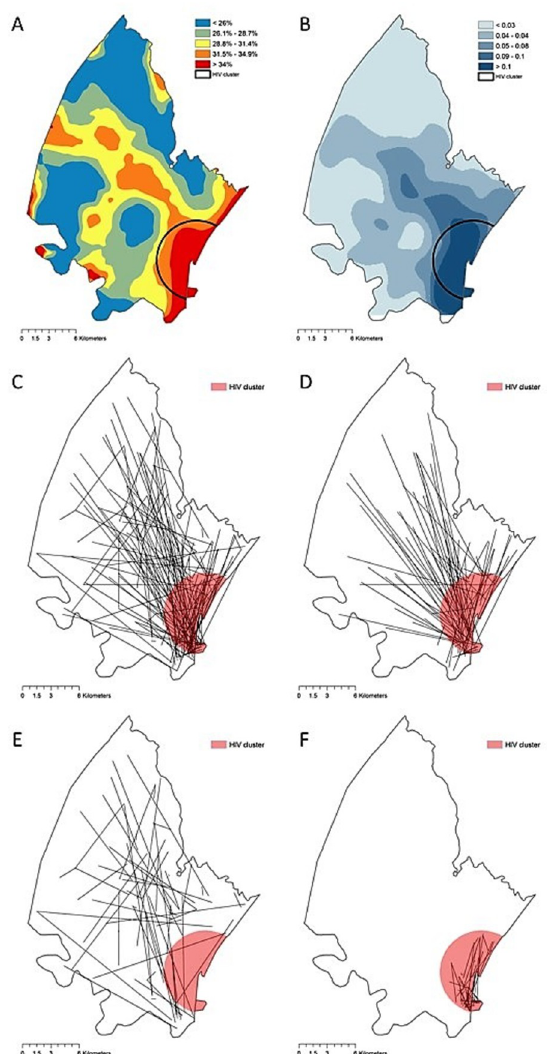
Fig 2. A) Kernel interpolation of the HIV prevalence in the area of study. B) Estimated HIV sero-conversion per pixel (300m x 300m). C) All transmission links. D) Transmission links in which at least one individual is located inside